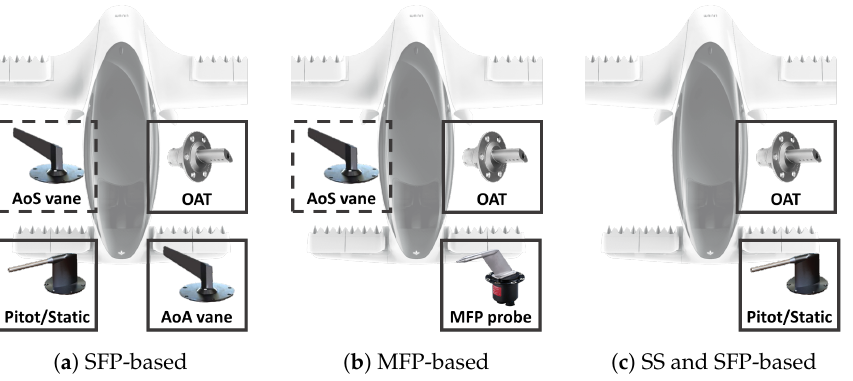
Figure 2. Generic three realistic simplex air data sensing architectures able to provide a complete set of air data. The dashed lines of AoS sensors indicate that they could not be